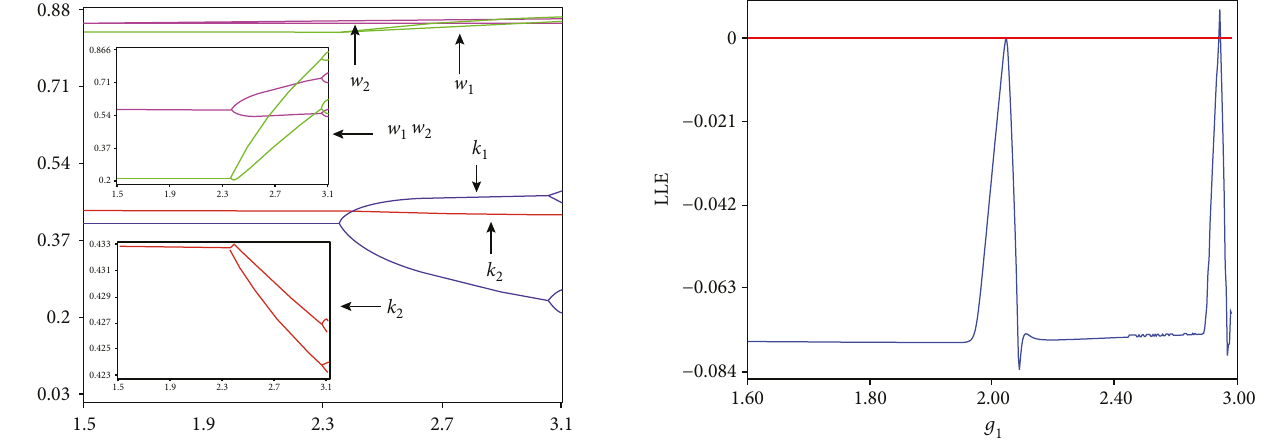
Figure 8: The largest Lyapunov exponent of the system with respect ∈ 1 5, 3 10 to g 1 ∈ 1 5, 3 10 . 1 , k 2 , w 1 , w 2 when g 1